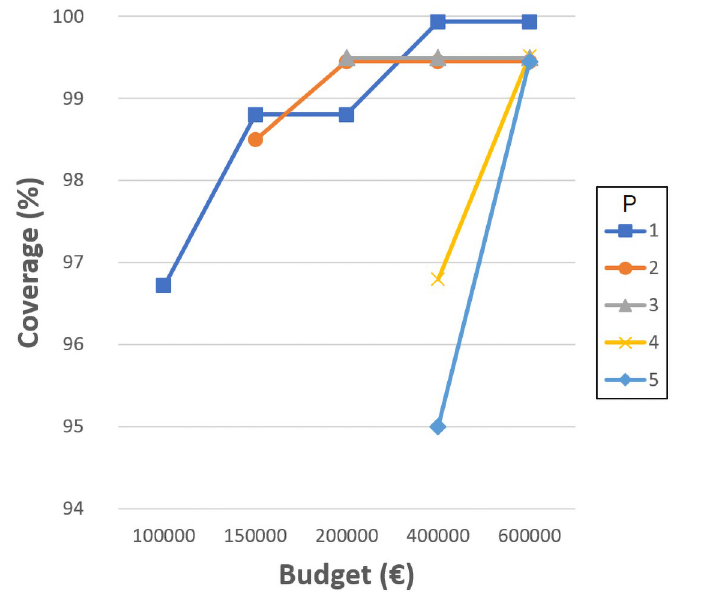
Fig 6. Coverages for 2000